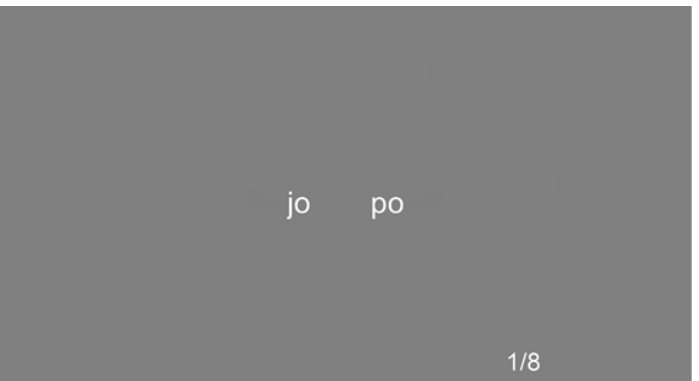
Figure 1. Example from the practice session of the identification task. Participants heard a single word over headphones and chose whether the word they heard was on the left or right by pressing the left or right arrow key.